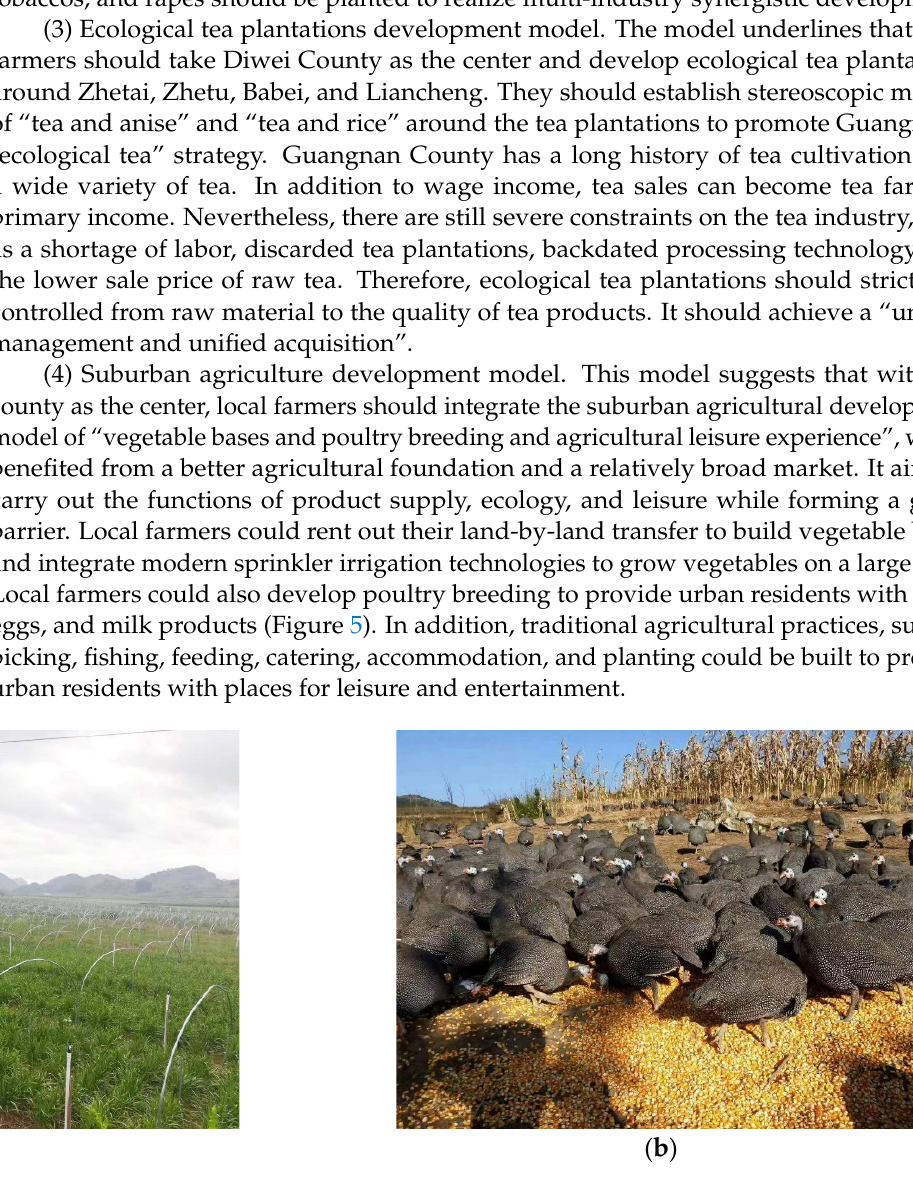
Figure 5. Examples of suburban agricultural development model. ( a ) Leek industry; ( b ) Poultry breeding).